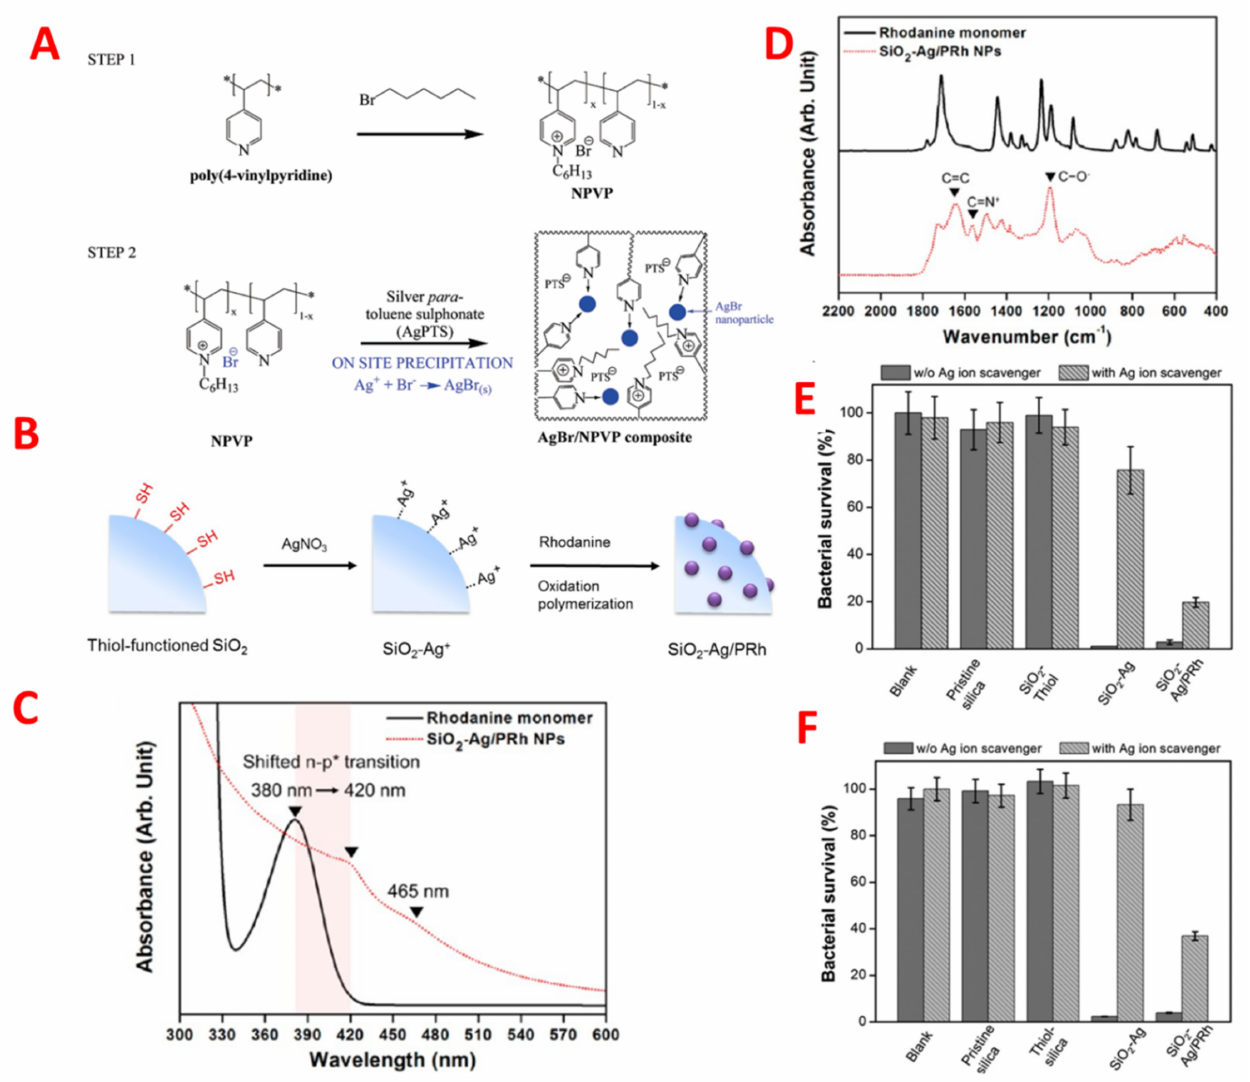
Figure 5. ( A ) Schematic of on-site precipitation method for the synthesis of dual action antibac- terial composite material, AgBr/NPVP poly(4-vinylpyridine)-co-poly(4-vinyl- N -hexylpyridinium bromide). Adapted with permission from [31], published by American Chemical Society, 2006. ( B ) Schematic Illustration of the Synthetic Procedure for SiO2 − Ag/PRh Nanoparticles ( C ) FTIR and ( D ) UV − vis spectra of rhodanine monomer (black solid line) and SiO 2 − Ag/PRh nanoparticles (red dotted line). ( D , E ) Antibacterial assessment of four different particles (pristine silica, thiol-silane- treated silica, SiO 2 − Ag, and SiO 2 − Ag/PRh) dispersed in solution and blank water toward E. coli and ( F ) S. aureus with or without silver-ion scavenger (100 µ L of neutralizer solution) at pH 7.4. Adapted with permission from [33], American Chemical Society,